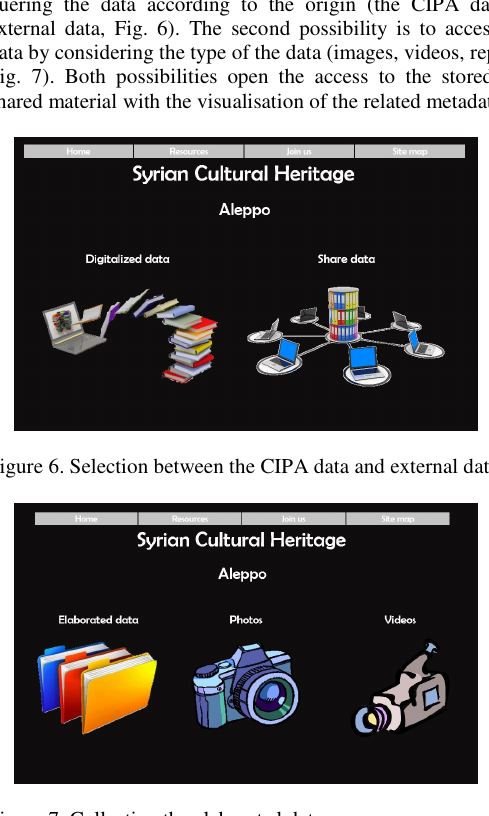
Figure 7. Collecting the elaborated data